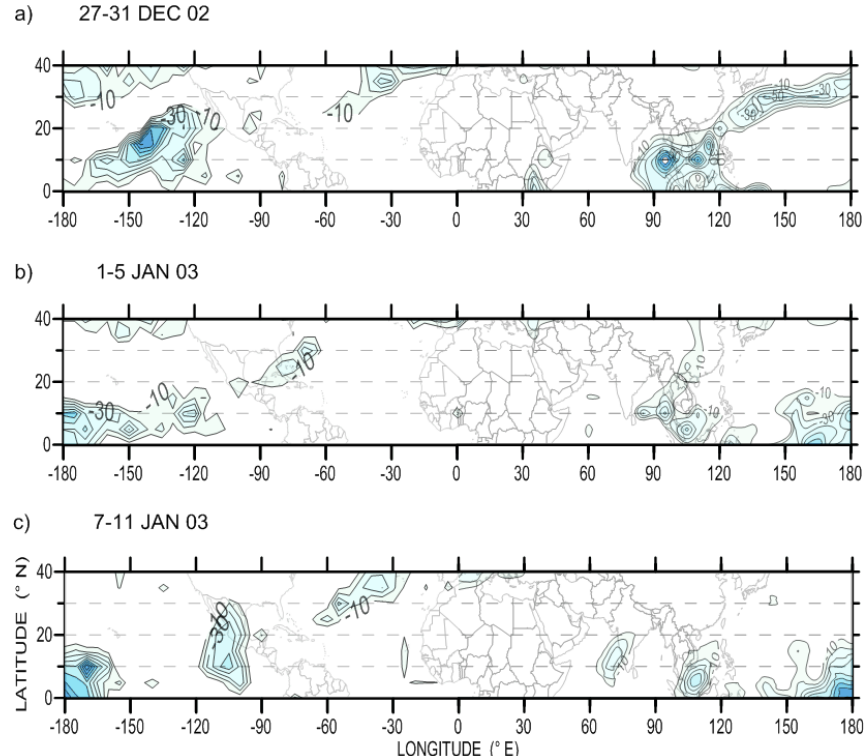
Fig. 7. Longitudinal anomalies of OLR (W/m 2 ) in latitudinal belt from 0 ◦ until 40 ◦ N averaged over the period 27–31 December 2002 (a) , Figure 7: Longitudinal anomalies of OLR (W/ m 2 ) in the latitudinal belt from 0° until 40° N 1–5 January (b) and 7–11 January 2003 (c) . Only negative anomalies are plotted indicating upper tropospheric divergence. averaged over the period 27 – 31 December 2002 (a) , 1- 5 January (b) and 7-11 January 2003 (c). Only negative anomalies are plotted indicating upper tropospheric divergence.